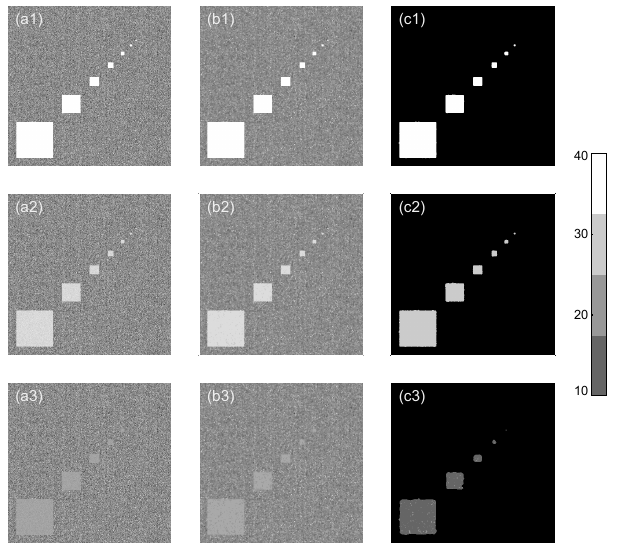
Figure 5. Panels (a1) , (a2) and (a3) are three “square clouds” that have strong, moderate and weak SNR values with random Gaus- sian noise used to test the detection method. Panels (b1) , (b2) and (b3) are SNR distributions after convolving the data with a bilateral kernel. Panels (c1) , (c2) and (c3) are the final cloud mask filtered by the spatial filter.